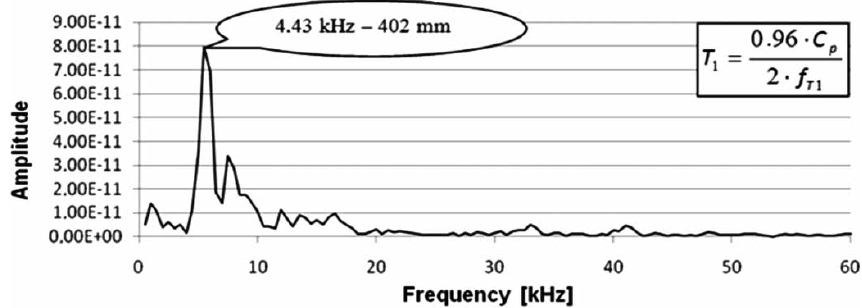
Fig. 13. Amplitude-frequency spectrum recorded in measuring place 11, using impact-echo technique